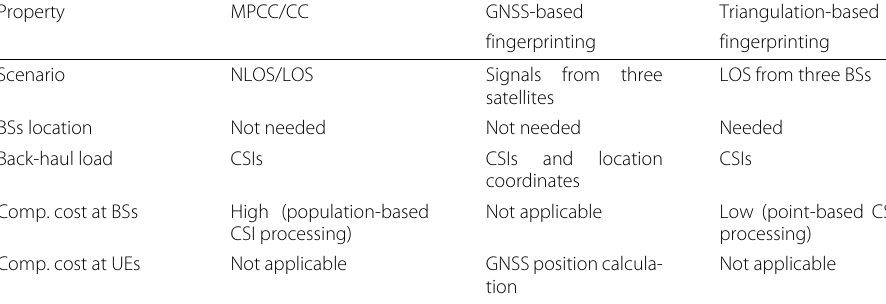
Table 1 Benefits and costs of CC-based